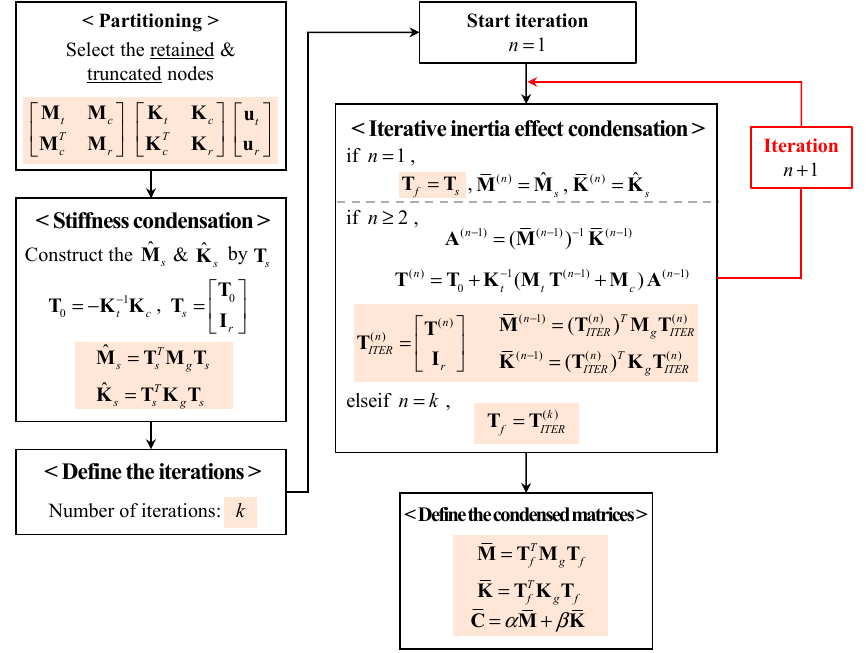
Figure 5. Procedure to calculate condensed mass, stiffness, and damping matrices.